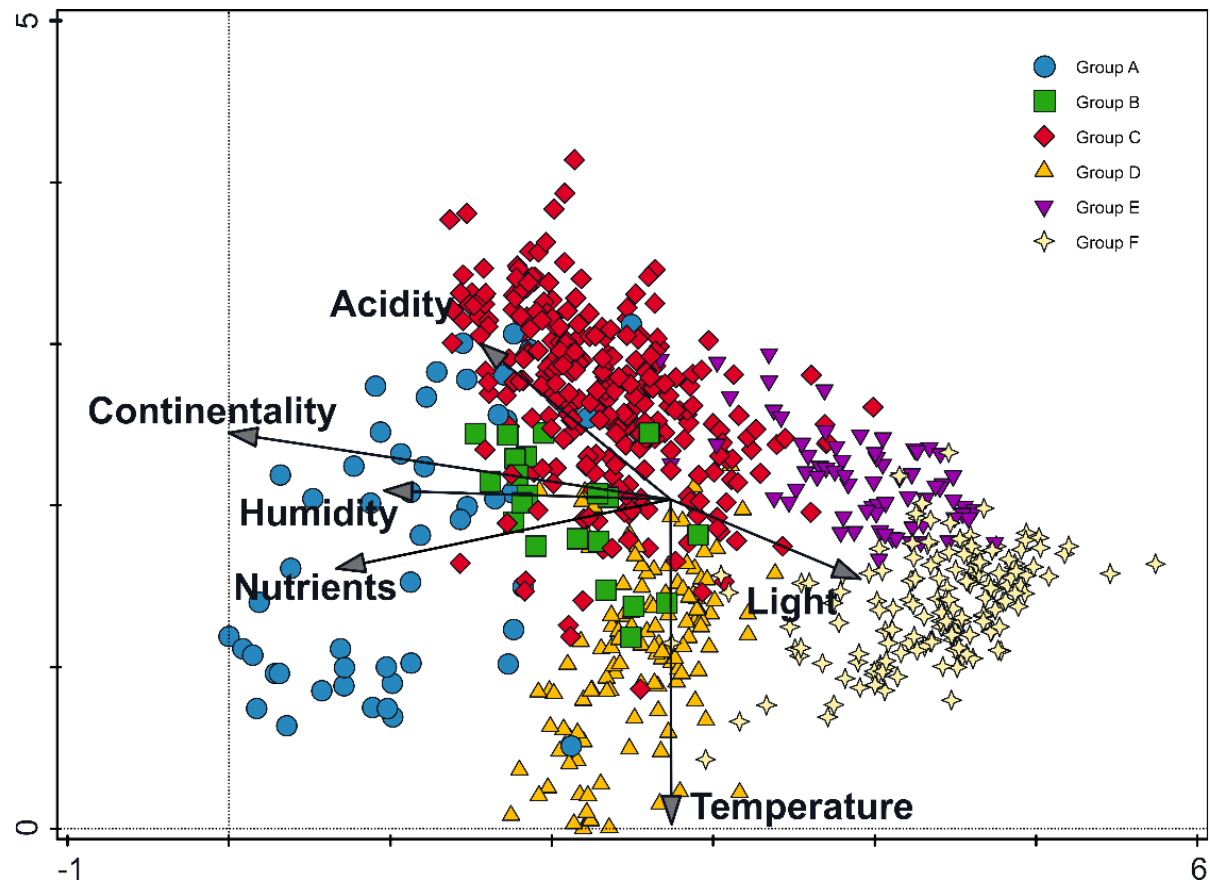
Figure 3. DCA ordination diagram of 6 major groups of ruderal vegetation (A, B, C, D, E, F), with passively projected ecological indicator values.